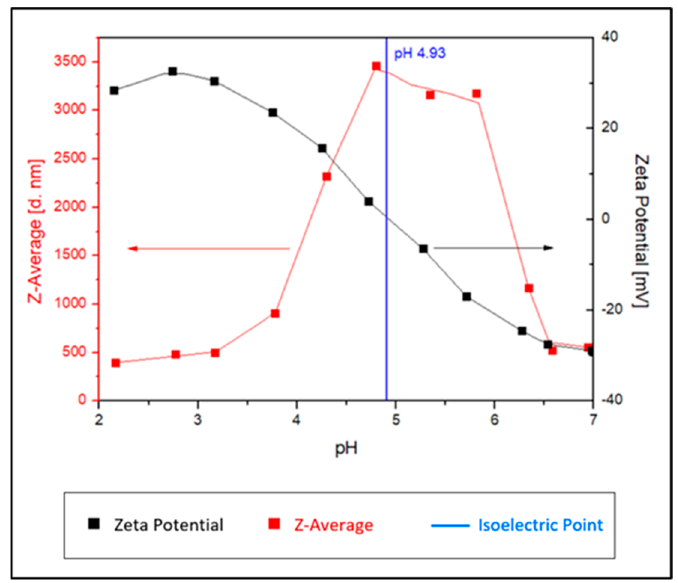
Figure 4. Change of zeta potential for Fe 3 O 4 @CA MNPs with pH values.